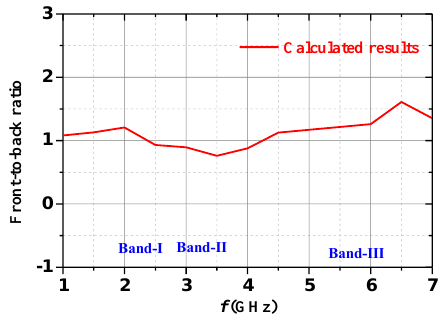
Figure 17. Front-to-back ratio of the proposed antenna.